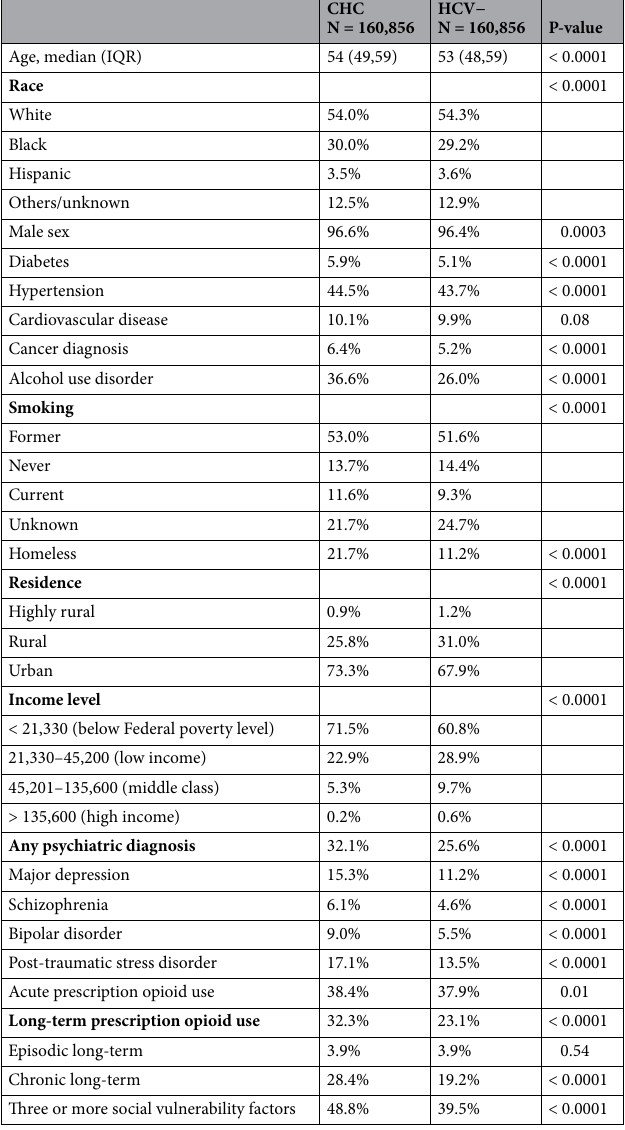
Table 1. Baseline characteristics of persons with CHC and propensity score matched HCV-uninfected controls. HCV, hepatitis C virus; CHC, chronic hepatitis C virus